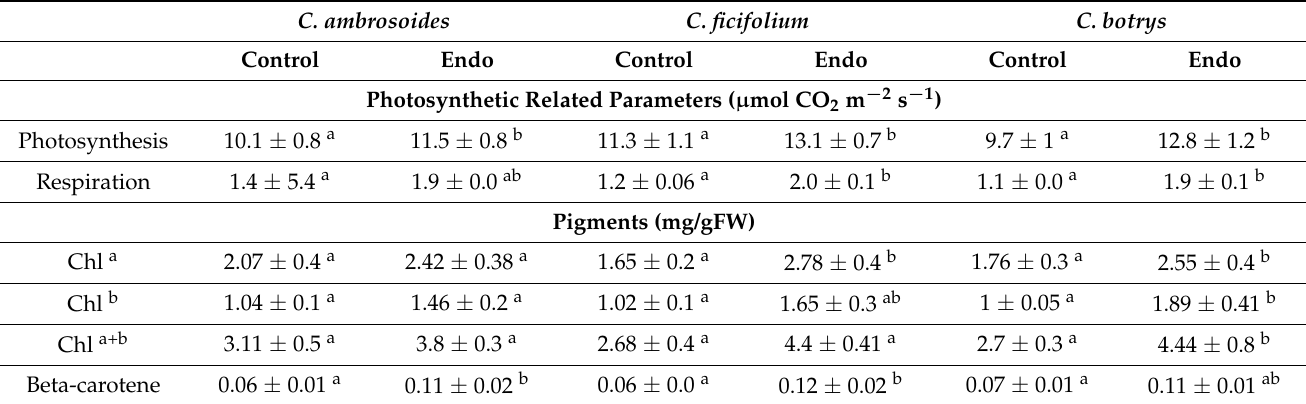
Table 2. Photosynthetic-related parameters and pigment contents of control and endophytic bacterial-treated Chenopodium ambrosoides, Chenopodium ficifolium, and Chenopodium botrys sprouts. Data are represented by the means of at least 3 replicates ± standard deviations. Different small letter superscripts (a, b) within a row indicate significant differences between control and endophytic bacterial